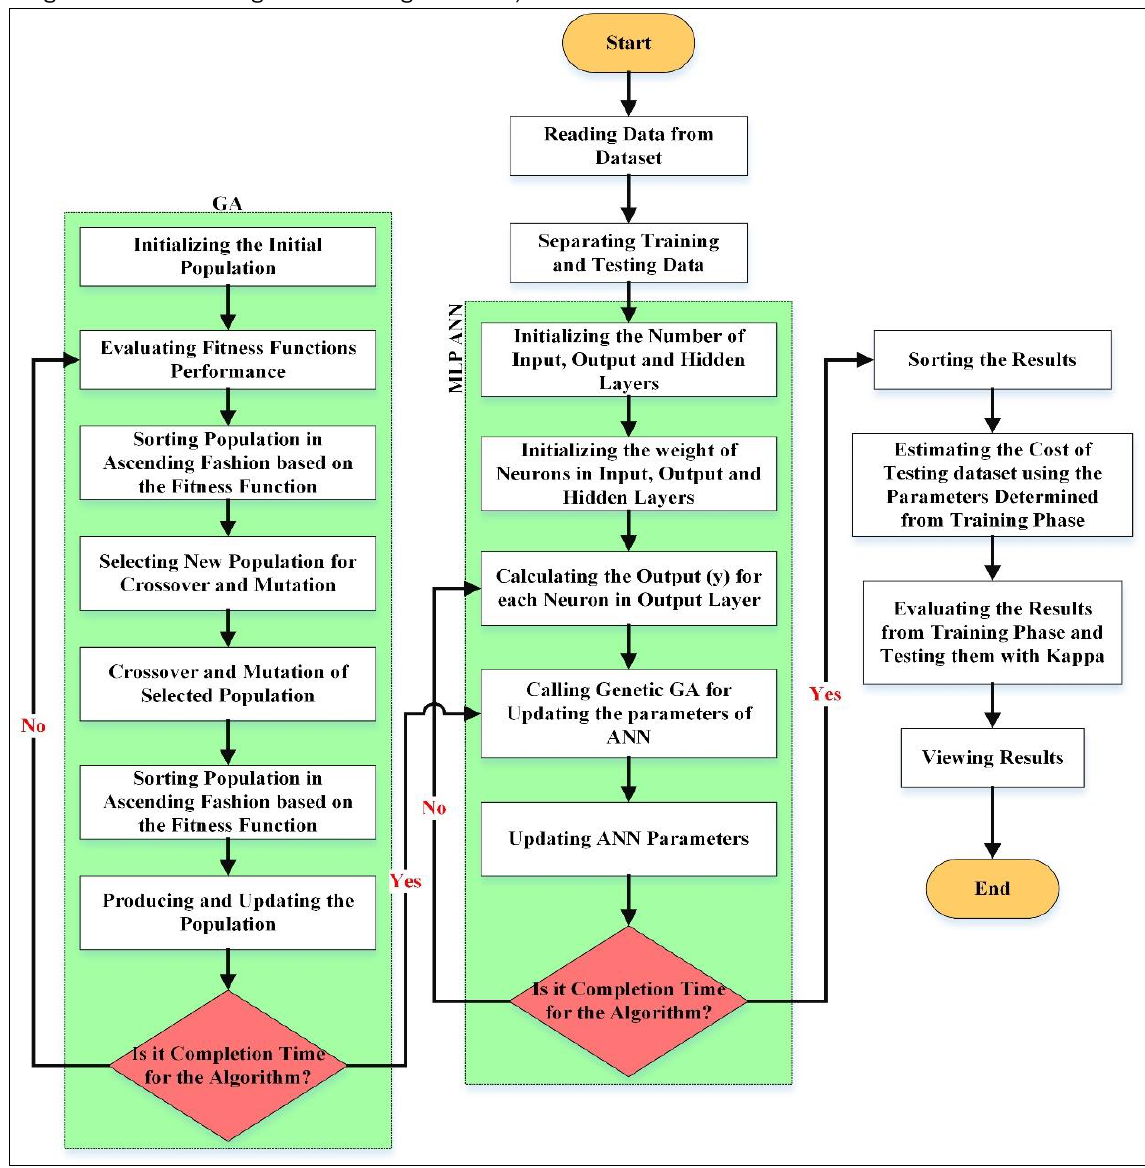
Figure 2. Process of proposed